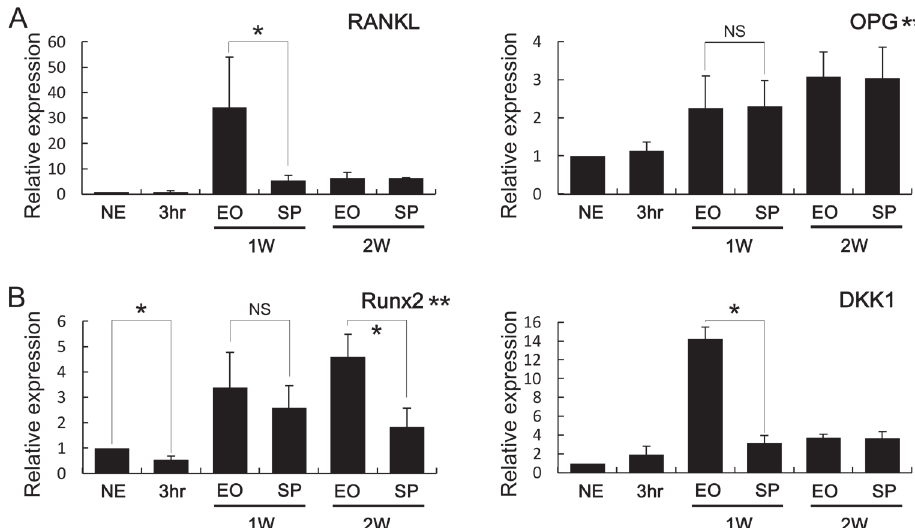
Figure 5- (A) mRNA expression related to osteoclastic activation. Levels of receptor activator of nuclear factor kappa-B ligand (RANKL) expression were significantly higher in the EO group 1 week after tooth extraction (1W). Osteoprotegerin (OPG) levels did not differ between groups; (B) mRNA expression related to osteoblastic activation. Levels of DKK1 expression were significantly higher in the EO group 1 week after tooth extraction. Levels of Runx2 mRNA were significantly higher in the EO than in the SP group 2 weeks post-extraction (2W). NE: no extraction; EO: extraction only; SP: extraction